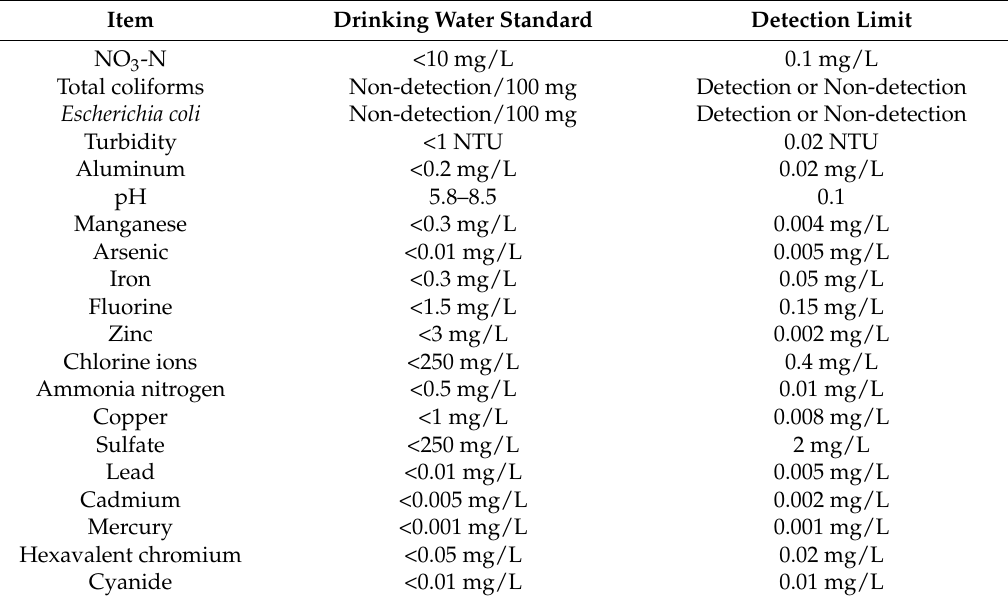
Table 4. Drinking water standards and detection